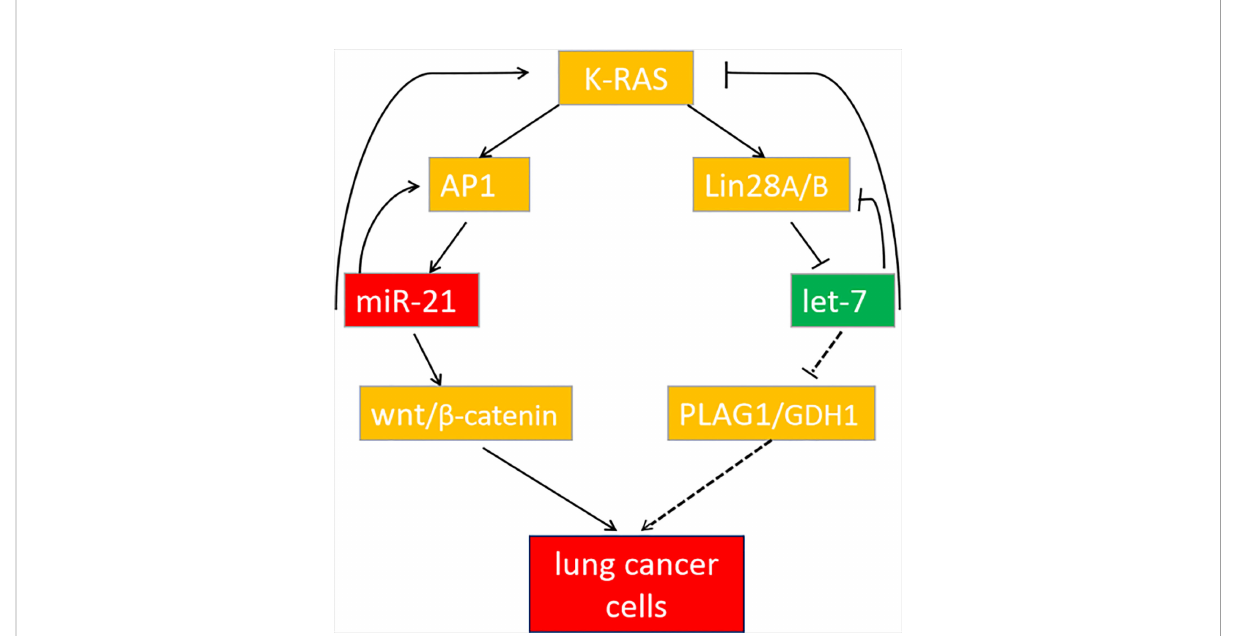
FIGURE 9 The feedback pathway between miR-21 and let-7. The arrow indicates positive regulation, and the horizontal line indicates negative